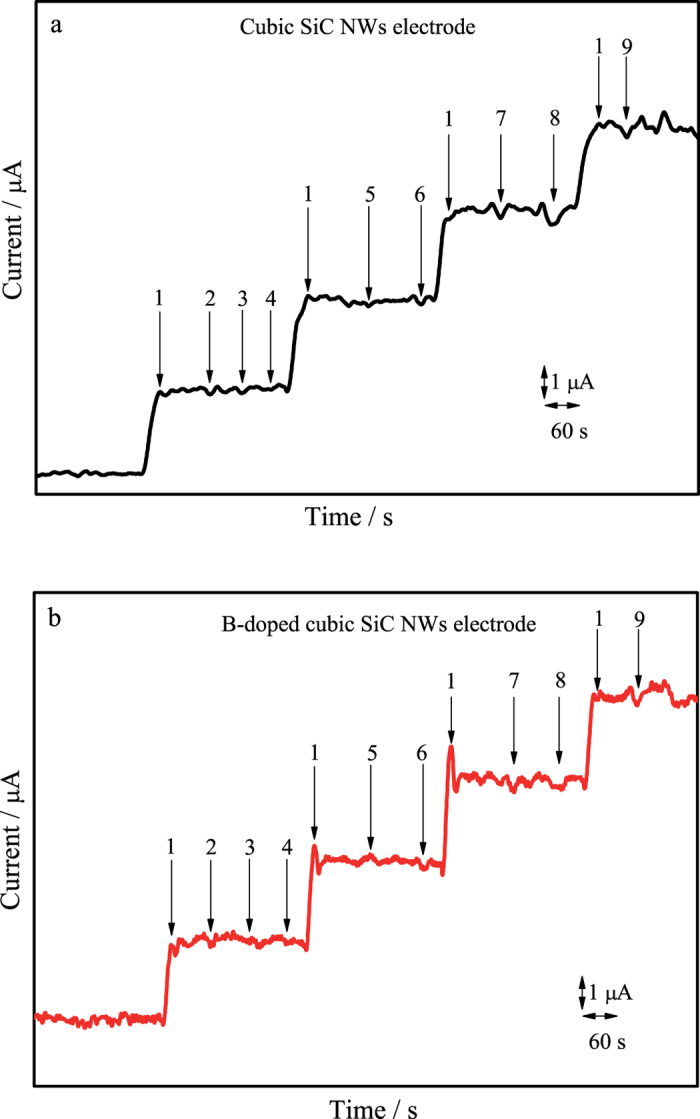
The amperometric response at the cubic SiC NWs electrode (a) and B-doped cubic SiC NWs electrode (b) for nitrite (1) in the presence of 100-fold: NaNO3 (2), CuSO4 (3), NaCl (4), K2SO3 (5), FeCl2 (6) NaOH (7), urea (8), glucose (9).